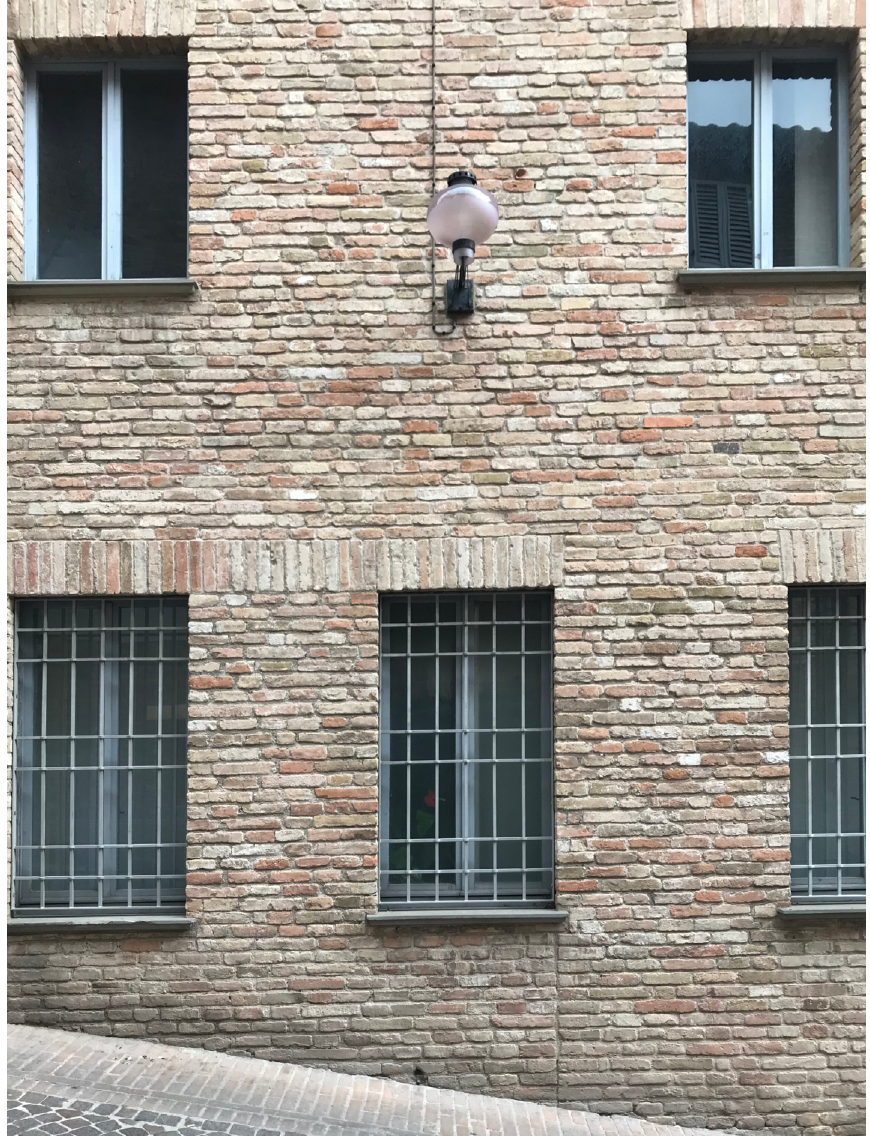
Fig. 9 The street-lamp in Urbino, its original context. Photo